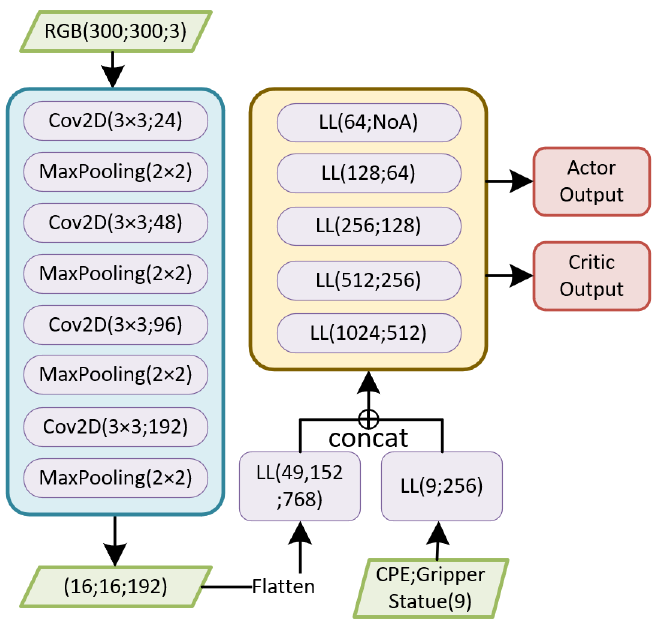
Figure 2. The architecture of the network. In the figure, FC indicates fully connected layer, and NoA indicates number of